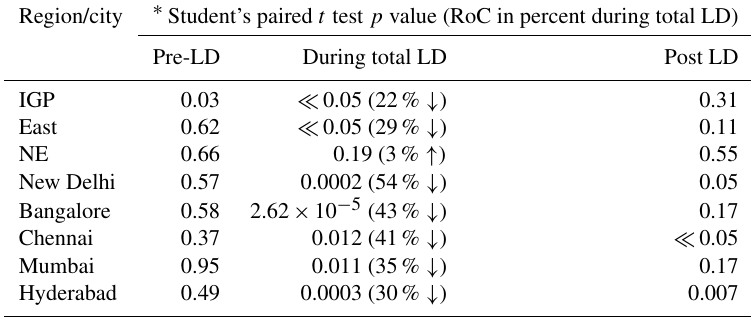
Table 2. Student’s paired t test for TCN during the lockdown period against the 5-year mean (2015–2019).